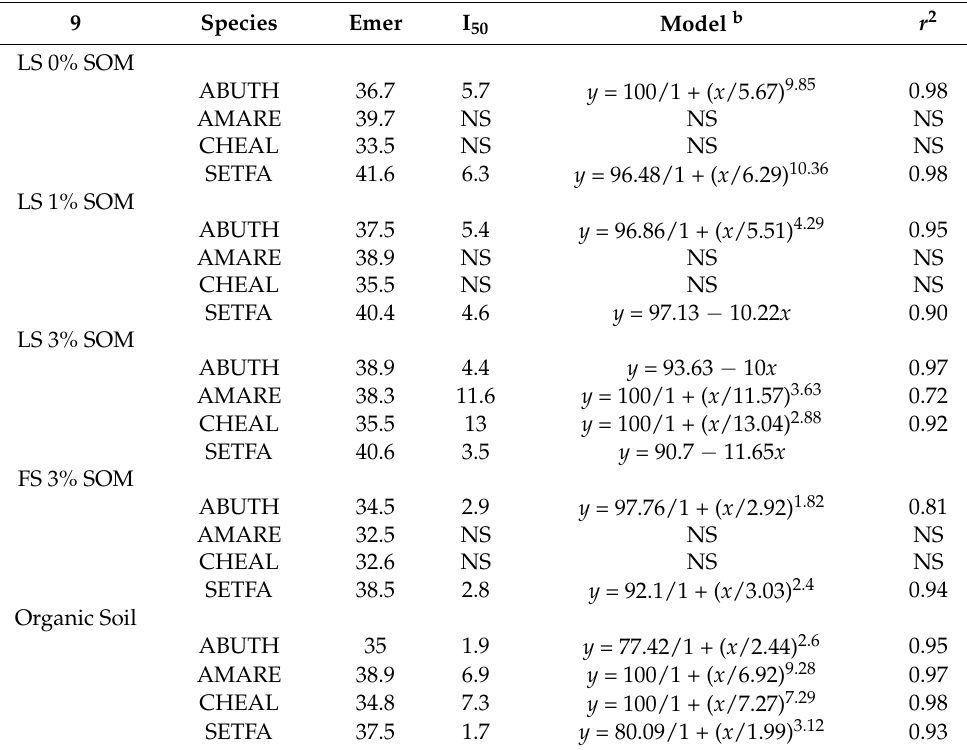
Table 4. Seedling emergence of various weed species averaged over time, I 50 , and regression equation used to model weed control for organic matter soils a